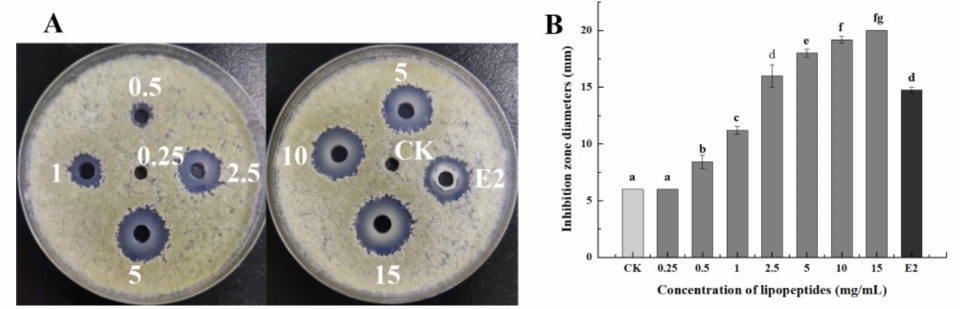
Figure 3. Strain E2 and different concentrations of LPs produced different sized inhibitory zones on the plates containing A. flavus . ( A ): Inhibition of A. flavus treated with strain E2, LPs (0.25–15 mg/mL), and SDW (CK). ( B ): MIC inhibitory concentrations of LPs. The numbers of 0, 0.25, 0.5, 1, 2.5, 5, 10, 15 mg/mL and CK represent different concentrations of LPs and cell suspensions of strain E2 at the concentrations of 1 × 10 9 CFU/mL, respectively. Different letters above the bars indicate significant differences (LSD test, p <